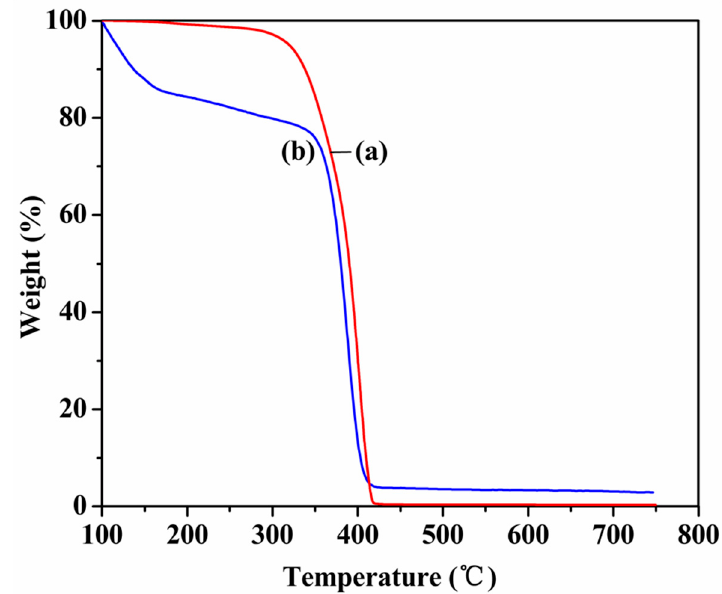
Figure 6. TGA weight loss curves of ( a ) neat HPEI and ( b ) ZnO 1:2 /HPEI-10 nanocomposites. The heating rate was 20 °C/min under N 2 atmosphere.